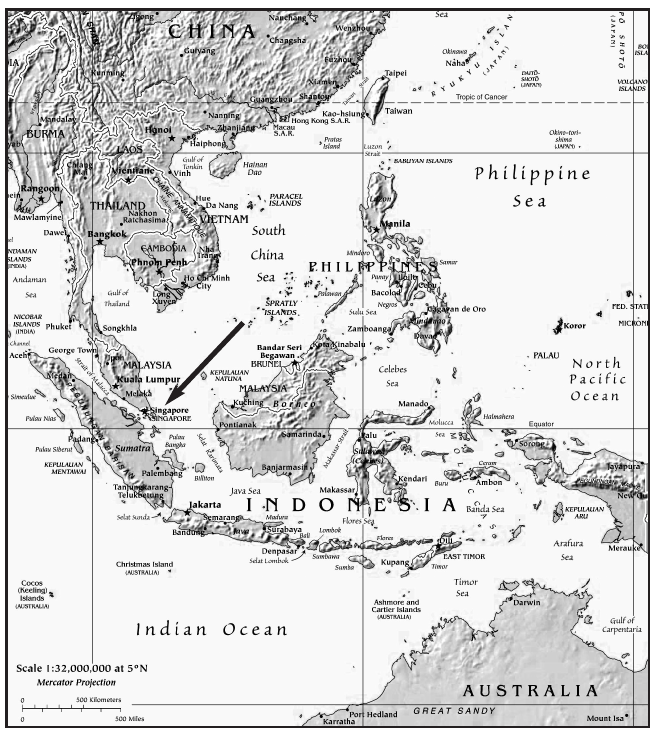
Figure 1. Singapore Is a Tiny Nation-State Located in Southeast Asia